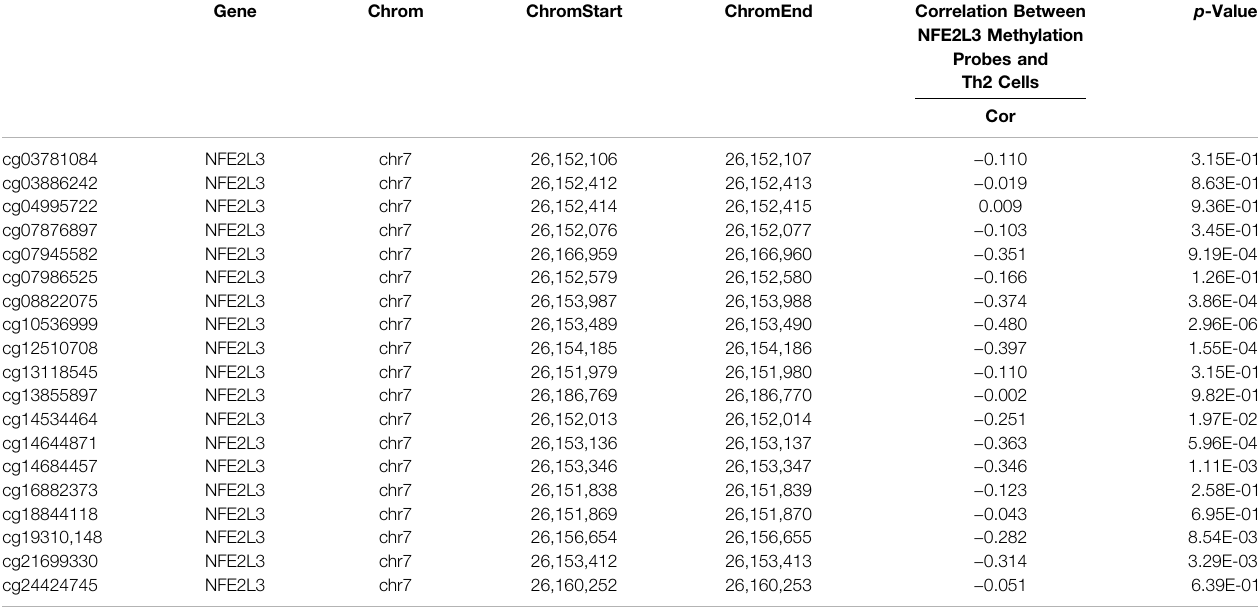
TABLE 1 | The basic information of DNA methylation sites of NFE2L3 and the correlations between their methylation levels and Th2 cell in fi ltration. Chrom, chromosome; ChromStart, starting position in the chromosome; ChromEnd, end position in the chromosome. Gene Chrom ChromStart ChromEnd Correlation Between